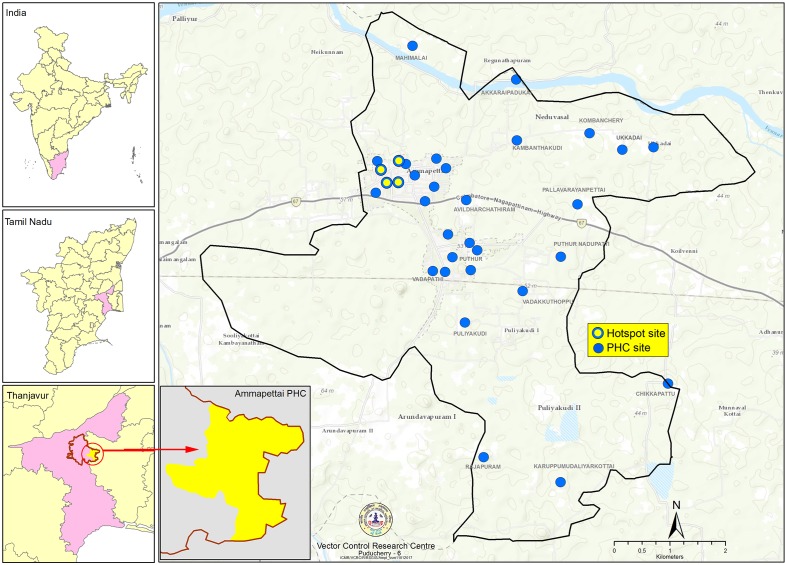
Map of study area, hotspot evaluation unit sites, and PHC evaluation unit sites.